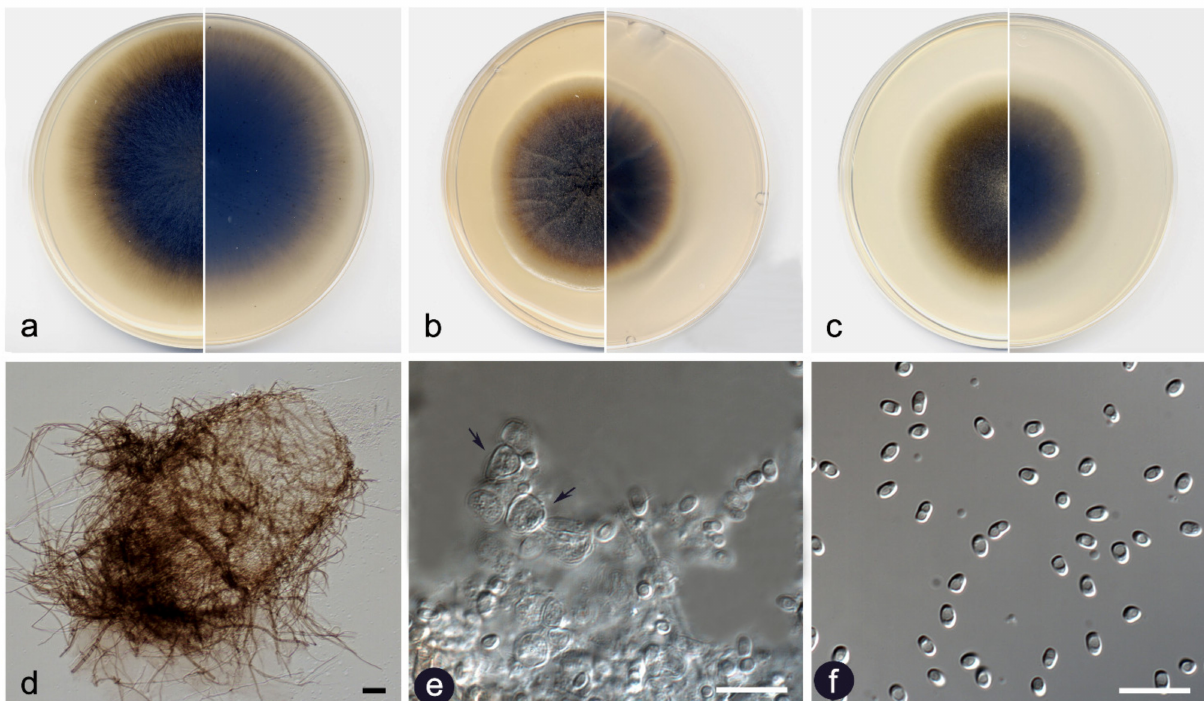
Figure 5. Paraboeremia clausa FMR 18597: ( a ) colonies on OA; ( b ) MEA; and ( c ) PDA after two weeks at 25 ± 1 ◦ C (surface, left; reverse, right); ( d ) pycnidium; ( e ) conidiogenous cells (black narrows); ( f ) conidia. Scale bars: ( d ) = 50 µ m, ( e , f ) = 10 µ